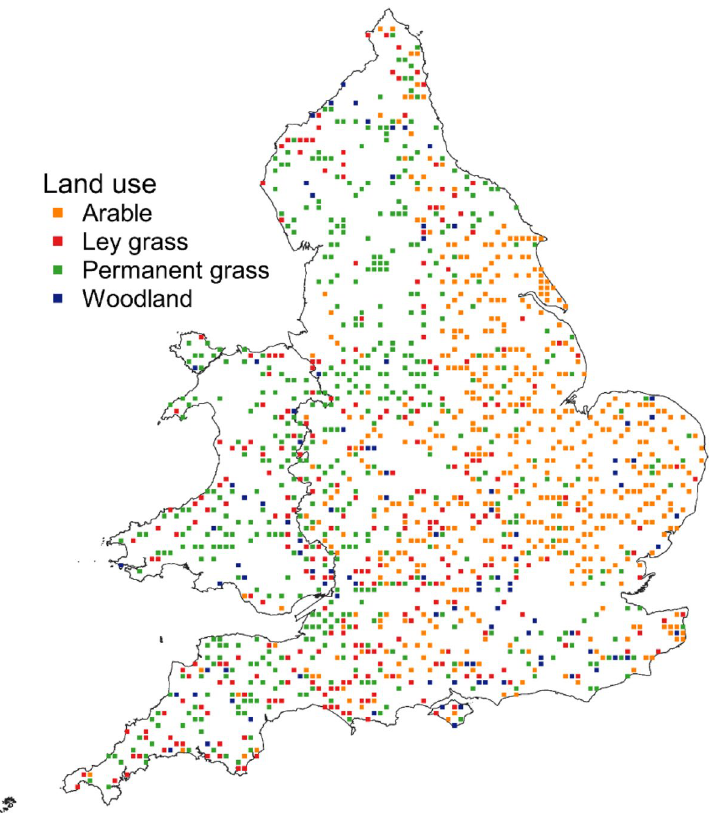
Figure 1. Distribution of National Soil Inventory sites selected for analyses ( n = 1418). The map was produced using QGIS 3.0.1-Girona 25 .